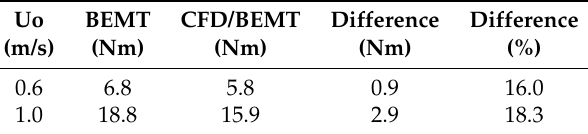
Figure 4. Rotor Torque for ( a ) Uo = 0.6 m/s and ( b ) Uo = 1.0 m/s. Table 4. Average turbine rotor